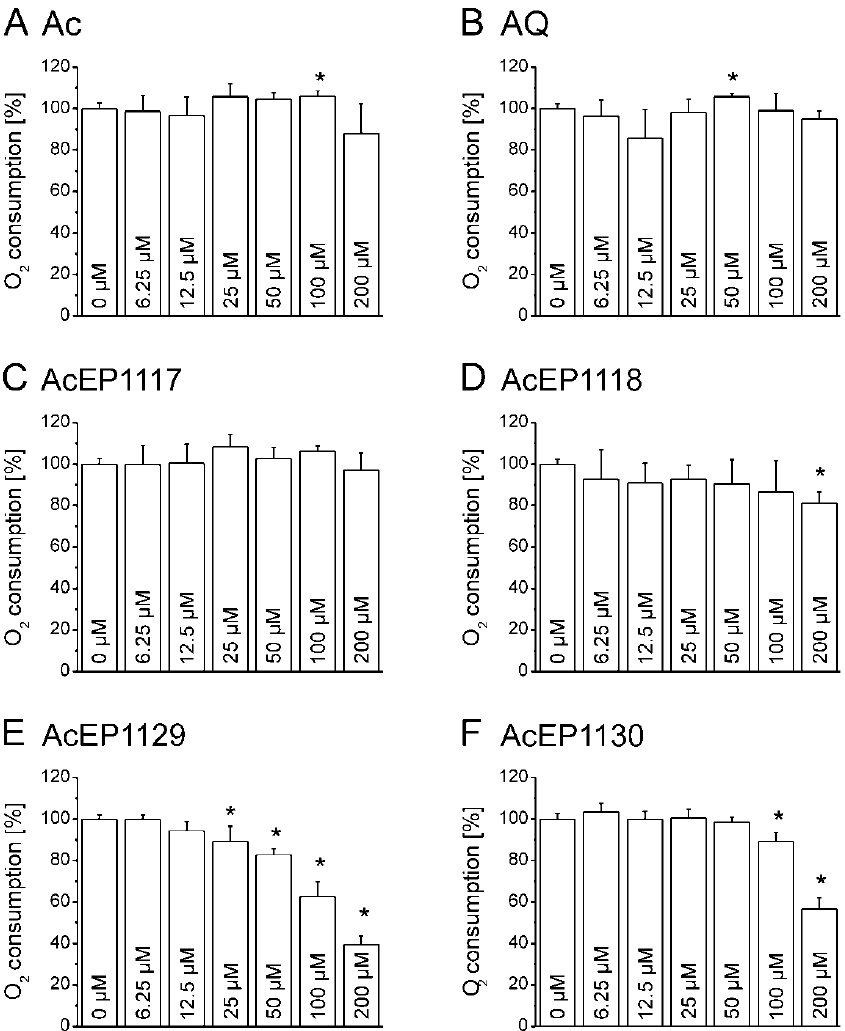
Figure 6. Influence of different anthracene derivatives on the oxygen consumption of LtP. LtP (140 × 10 6 cells/mL) were treated with 6.25 to 200 µM of Ac ( A ), AQ ( B ), AcEP1117 ( C ), AcEP1118 ( D ), AcEP1129 ( E ) or AcEP1130 ( F ) (max. vehicle concentration 1.5% DMSO). Untreated LtP in BHI medium served as reference (0 µM, 100%). Measurements were carried out using OxoPlates over an incubation time of 40 min. Data represent mean ± SD ( n = 3–4), * indicates significant differences to the control samples (0 µM) at the level of p < 0.05.